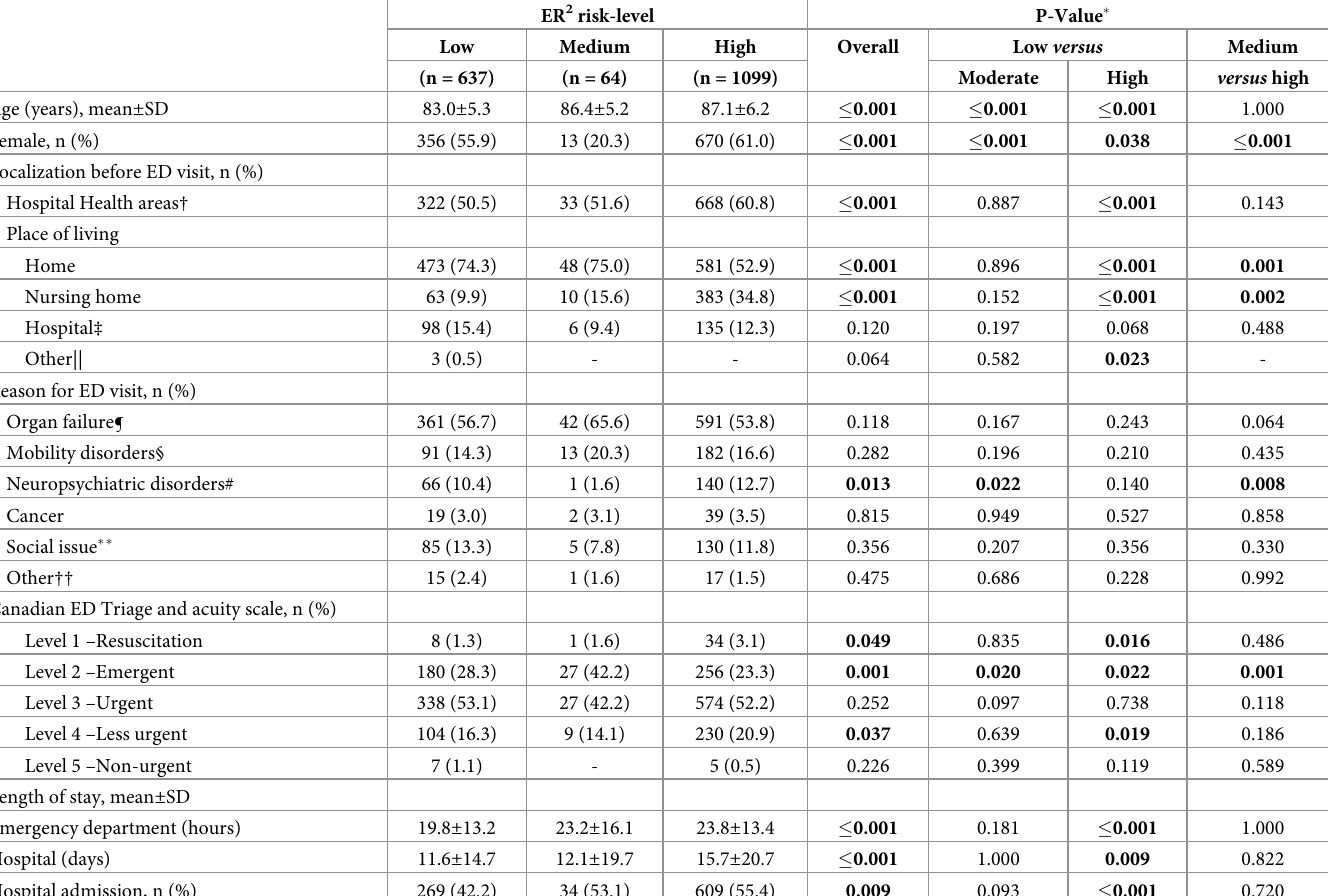
Table 1. Comparison of baseline characteristics of participants on stretcher visiting emergency department who had Emergency Room Evaluation and Recommen- dation (ER 2 ) assessment completed separated according to their risk-level for short-term undesirable outcomes (n =